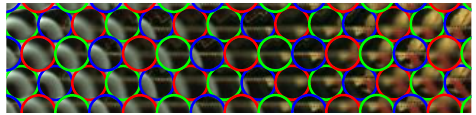
Figure 1. Cross view of the two possible configurations (Keple- rian and Galilean) of a focused plenoptic camera.